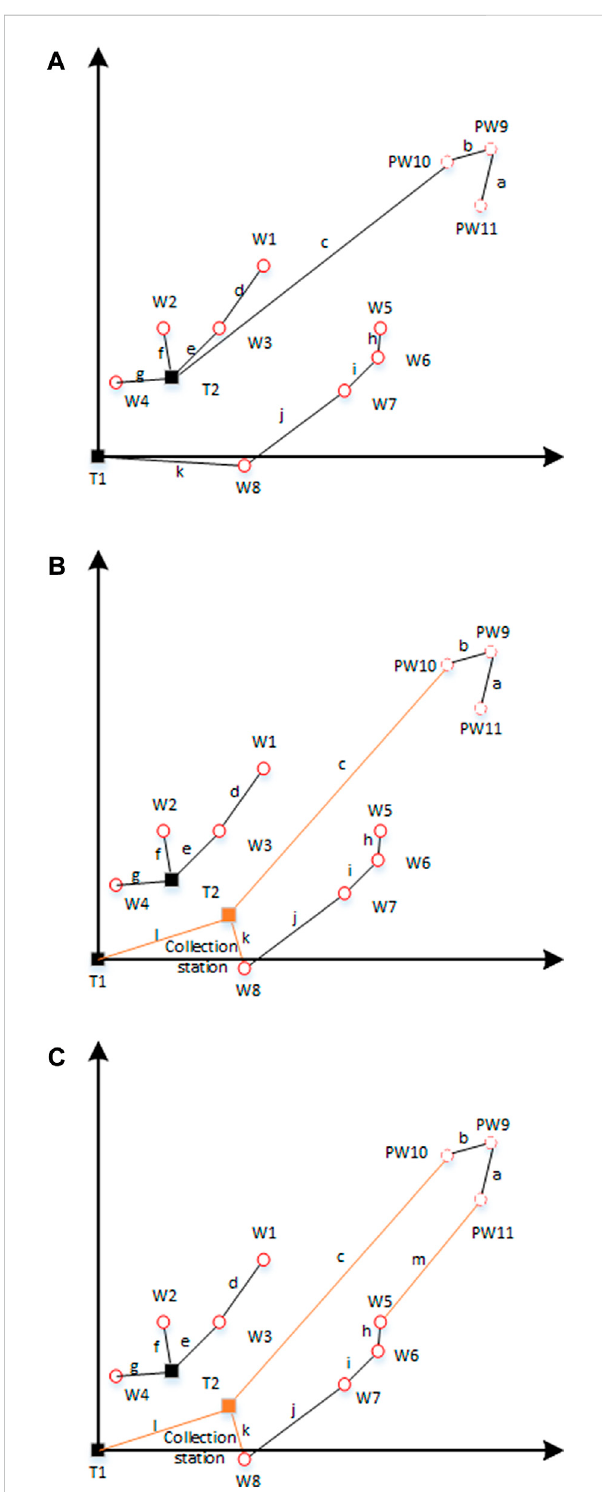
FIGURE 7 Topological diagram. (A) scheme I (point-to-point collection); (B) schemeII(starshapedcollection); (C) schemeIII(circulargathering